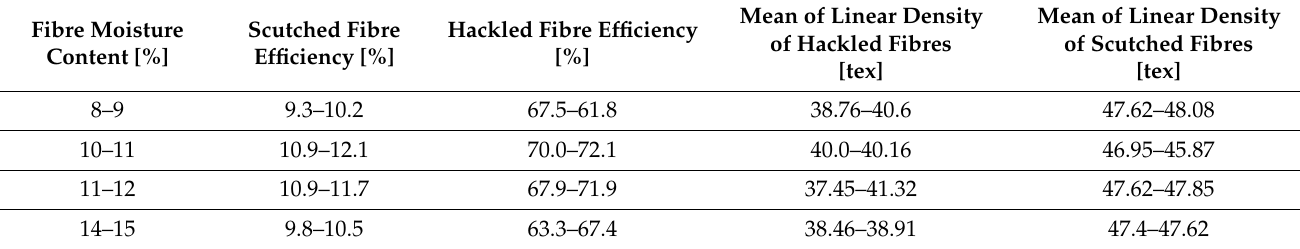
Table 6. Fibre moisture content effect on process efficiency and linear density of the